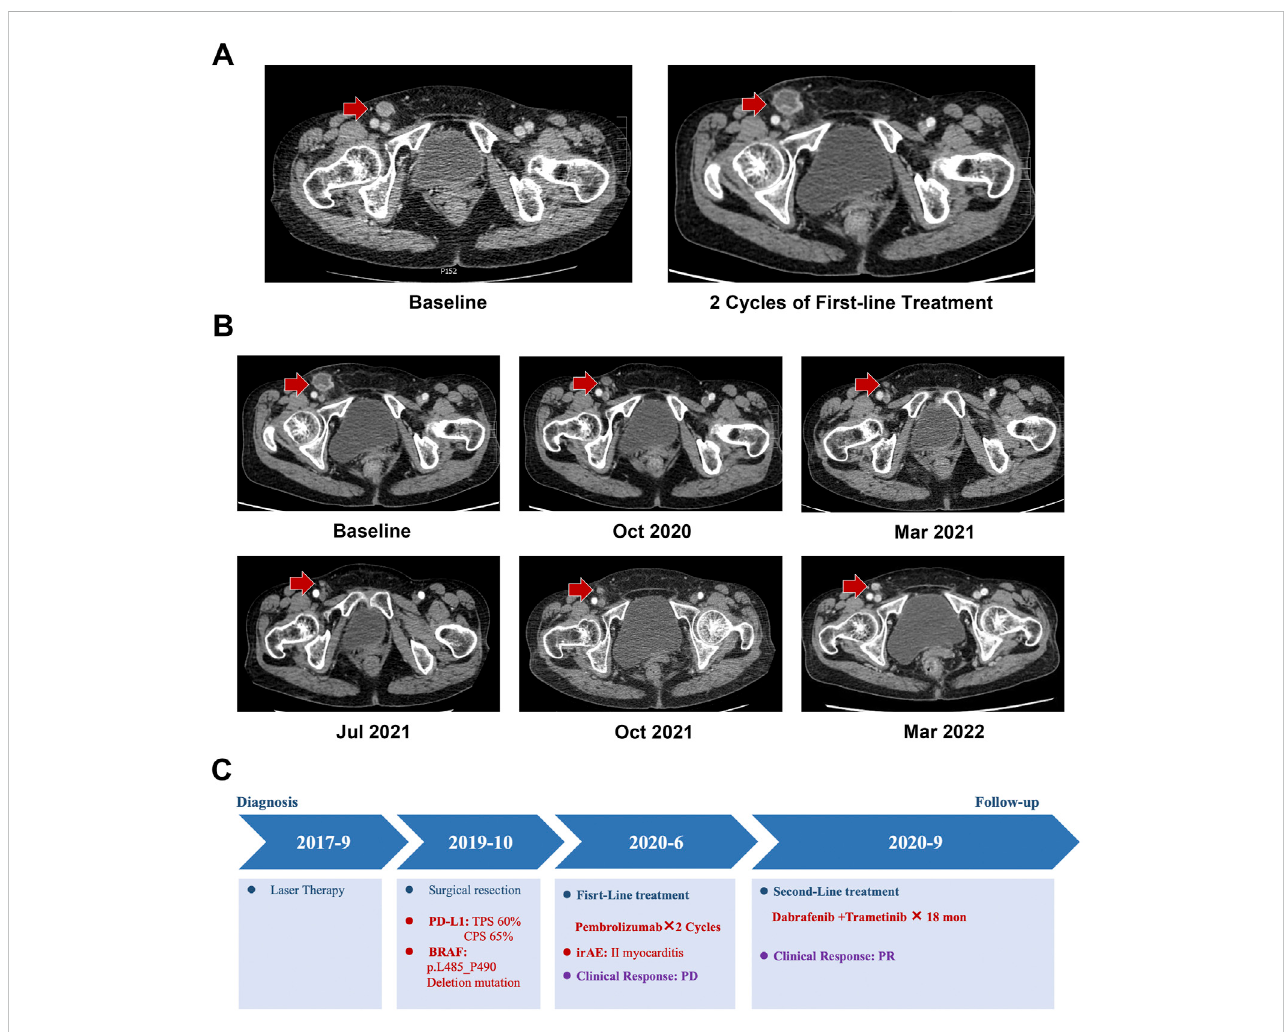
FIGURE 2 Medical imaging examination during the treatment period. (A) Progression disease (PD) con fi rmed by CT after two cycles of the fi rst-line treatment. (B) Contrast-enhanced abdominal CT showed that thetarget lesion presented partial response (PR) to the dabrafenib and trametinib combination treatment.